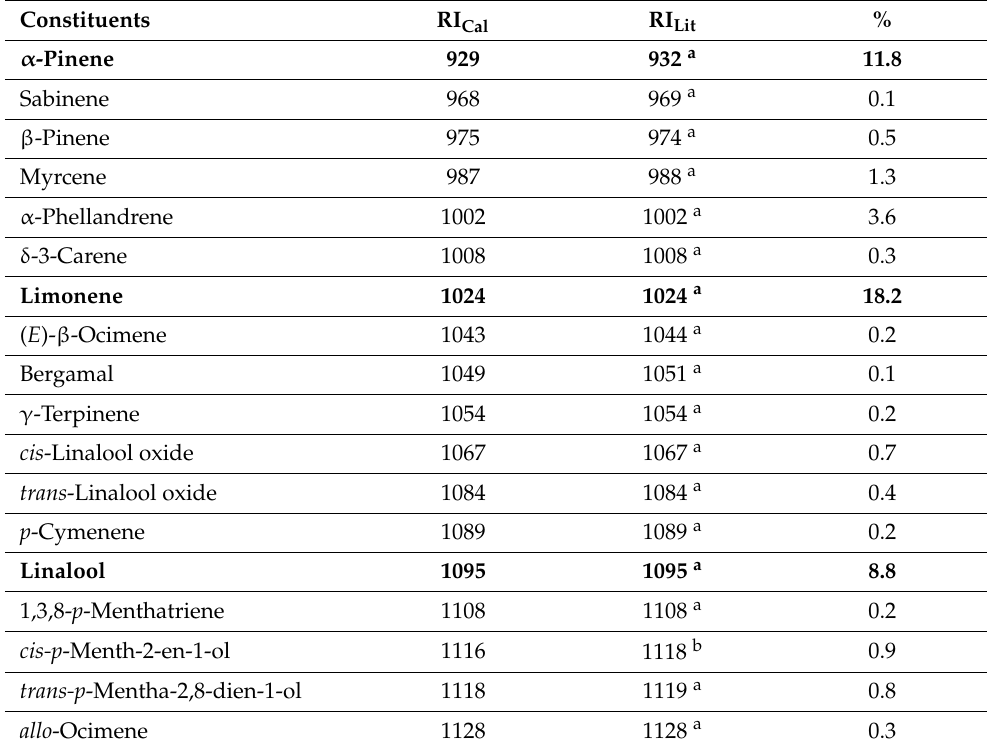
Table 1. Constituents identified in the volatile concentrate of C. alatum